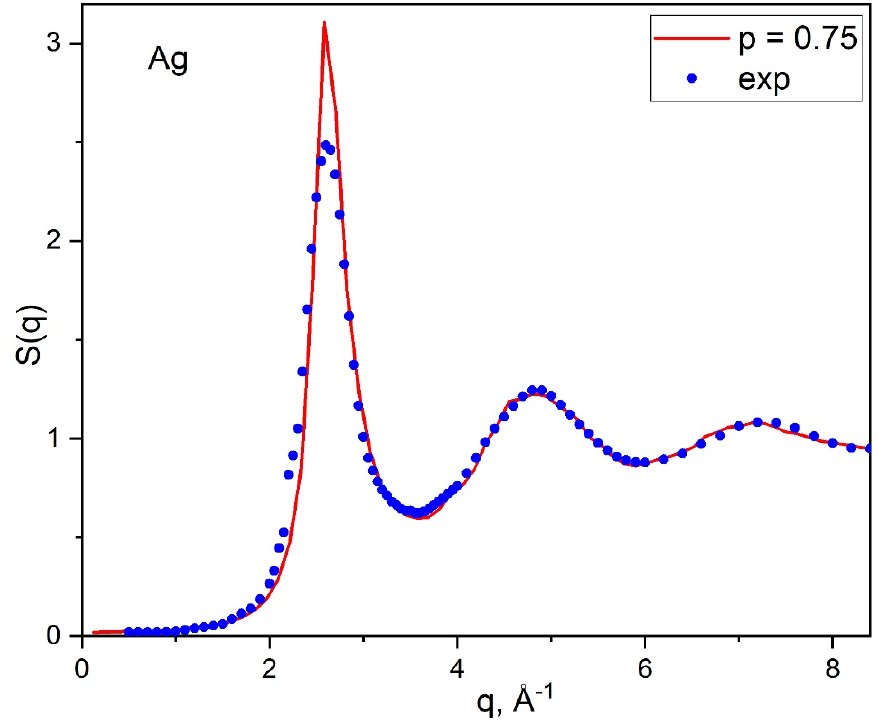
Figure 9. Structure factor of liquid Cu at T = 1423 K and p = 0.25 in comparison with experiment [38].